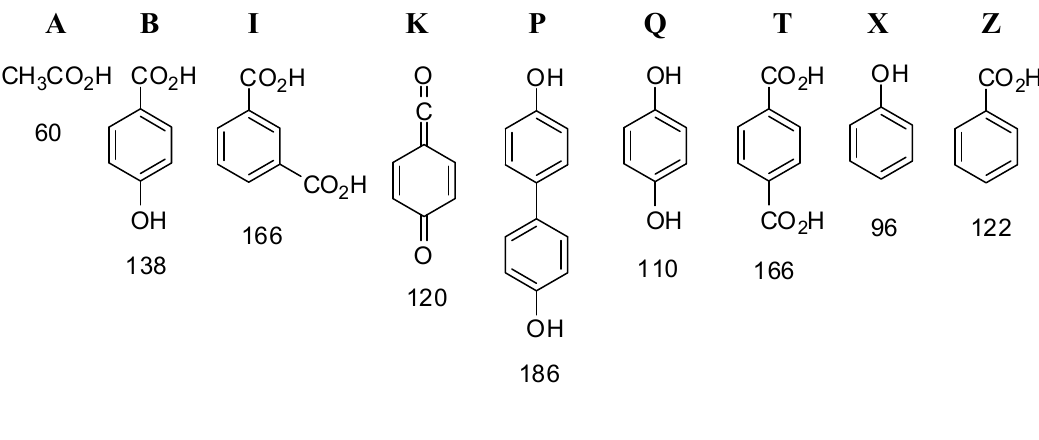
Figure 1. Structures of and abbreviations for compounds in this